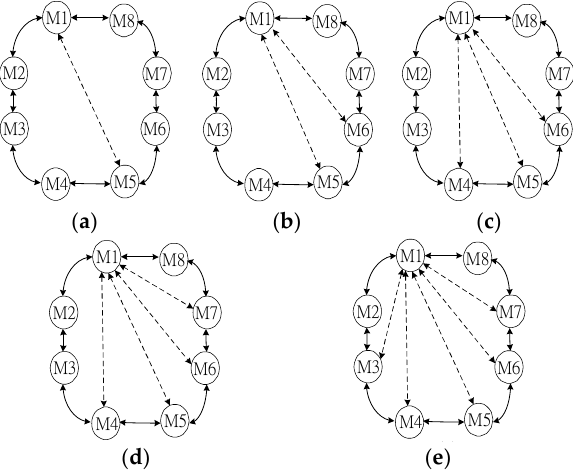
Figure 3. The possible mesh link connection examples for each master in a piconet: ( a ) The first mesh link connection; ( b ) The second mesh link connection; ( c ) The third mesh link connection; ( d ) The fourth mesh link connection; ( e ) The fifth mesh link connection.